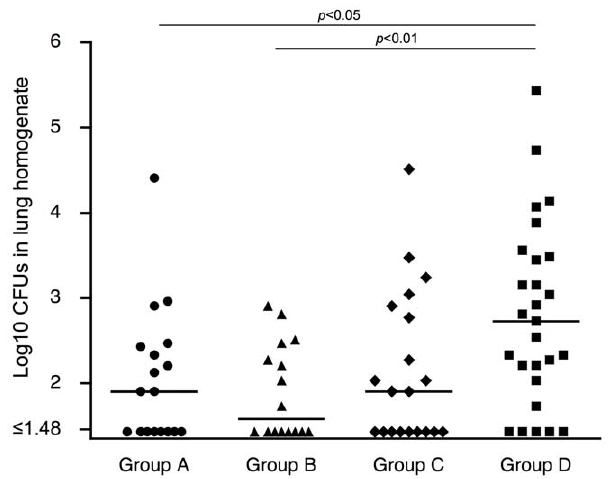
Figure 6. Protection against lung infection by maternal immunization with PspA among offspring. Seven-day-old mice were intranasally challenged with 5 6 10 5 CFU TIGR4 strain (10 m l/ mouse) with anesthesia. Three days after challenge, lungs were collected and the numbers of pneumococci colonies in the lung homogenate were determined. Each dot shows the Log 10 CFU/mouse. Each horizontal line shows the median Log 10 CFU/mouse. Group A (n=18), B (n=16), C (n=20), and D (n=27) mice were produced in the same manner as the corresponding groups in figure 3. p , 0.05 and p , 0.01 are p -values for differences between the indicated group and the non-immune mice in Group D by Kruskal-Wallis test with Dunn’s multiple comparison test.